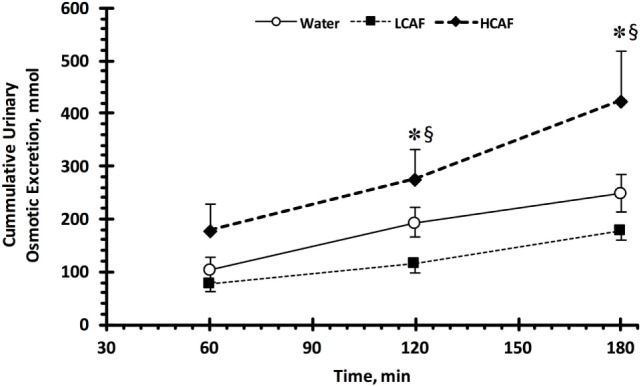
Cumulative urinary osmotic excretion. Low caffeine (LCAF) intake (3 mg kg−1); high caffeine (HCAF) intake (6 mg kg−1). Error bars depict SEM. * denotes statistically significant different from water trial during the same time-point. § denotes statistically significant different from LCAF trial during the same time-point.